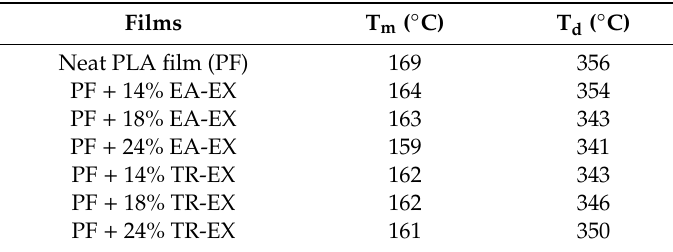
Figure 9. DSC of the PF and the UV-SF with different extracts content. Table 2. DSC results for PF and the UV-SF with extracts.